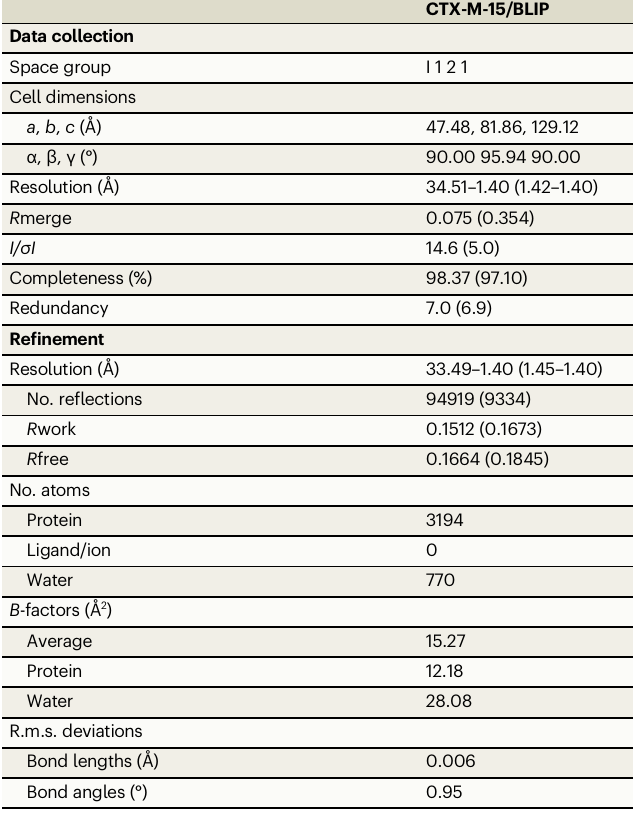
Table 1 | Crystallographic statistics for CTX-M-15/BLIP X-ray